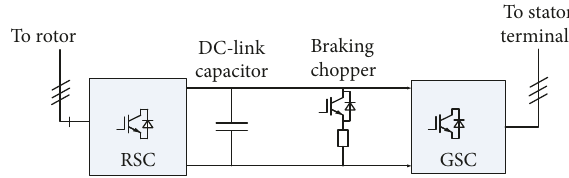
Figure 5: Power converter showing the chopper circuit